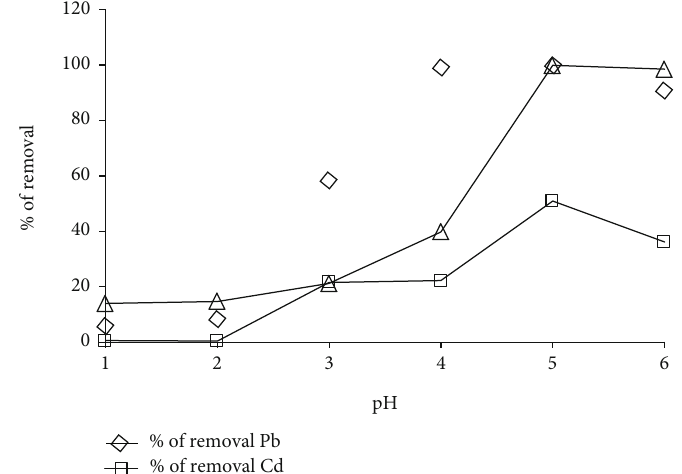
Figure 11: E ff ect of pH on the adsorption of (Pb +2 ), (Cr +3 ), and (Cd +2 ) ions; dosage of chelating resin: 1 g; ion concentration: 50 mg/L; time: 60min; and temperature: 25 °